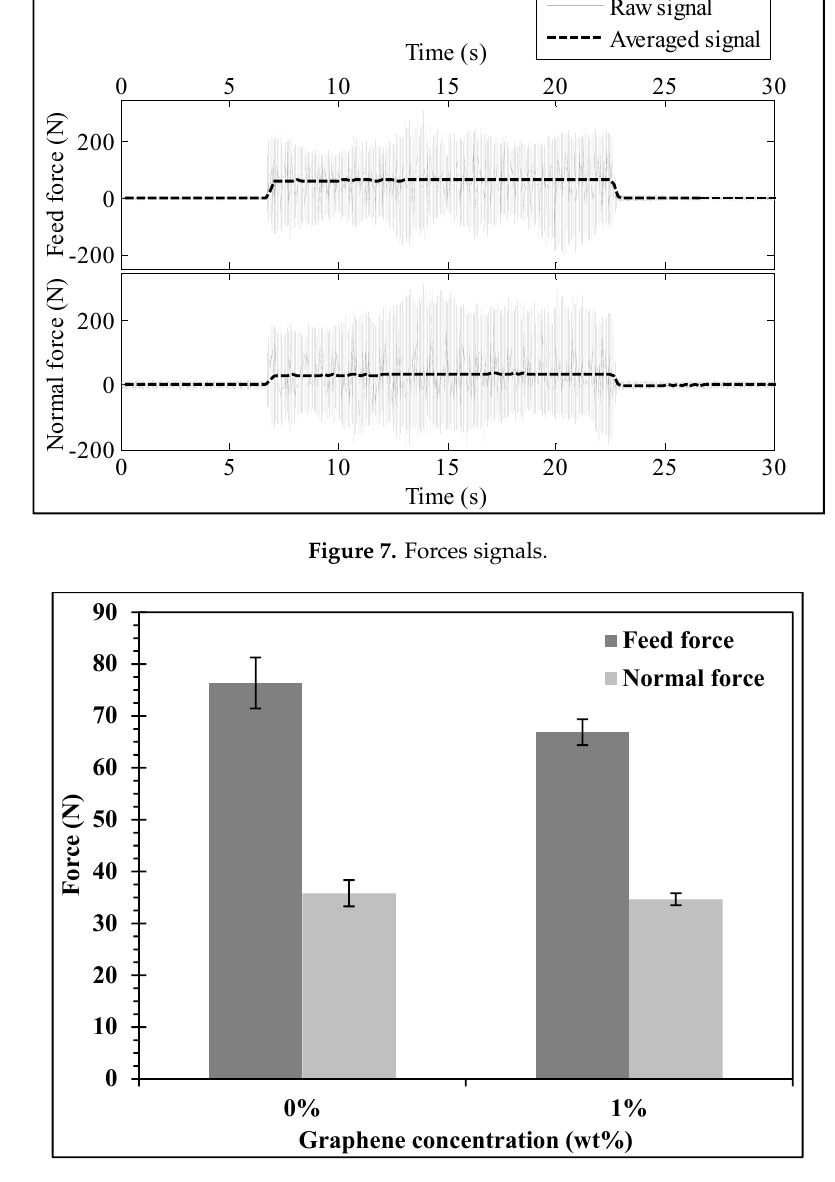
Figure 8. Cutting forces. Figure 8. Cutting